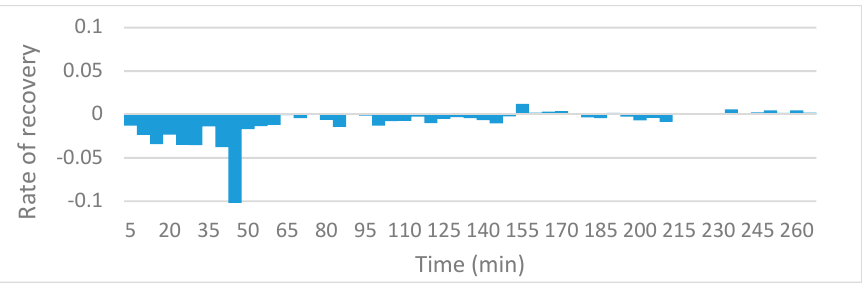
Figure 10. The slope function method to reveal the trend in local resistivity during brine-only run no.1.